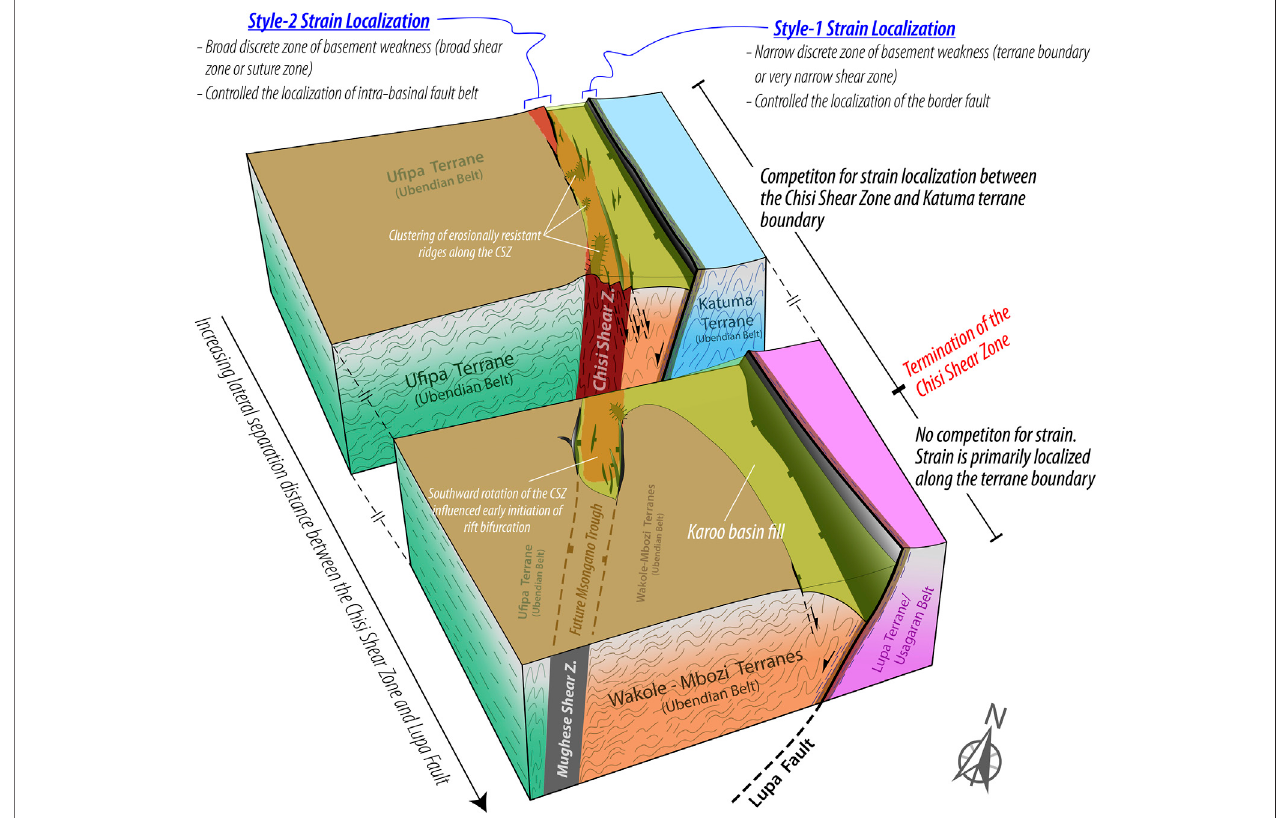
FIGURE 6 | Cartoon illustrating some of the key observations in this study, showing how the structure of discrete zones of basement weakness in fl uenced strain localization styles and along-rift distribution of extension during the early phase of tectonic extension in the Rukwa Rift.